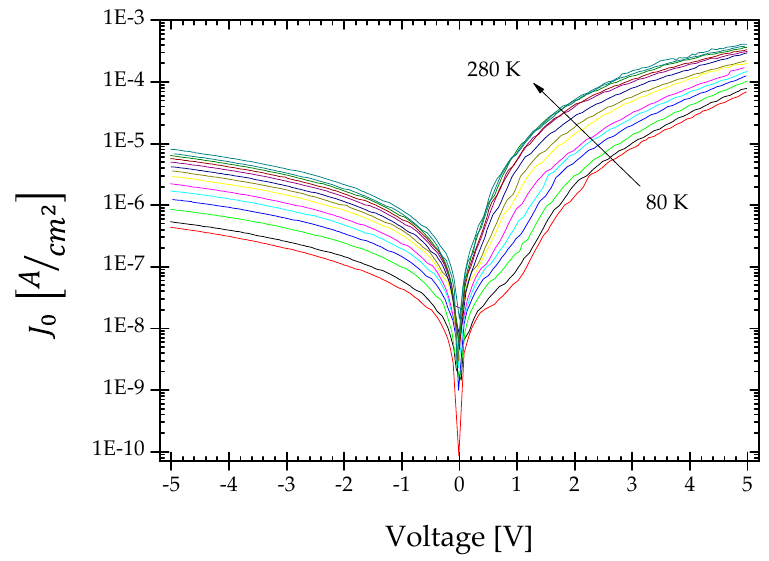
Figure 3. I-V-T characteristics of p-PCD/n-Si heterojunction.